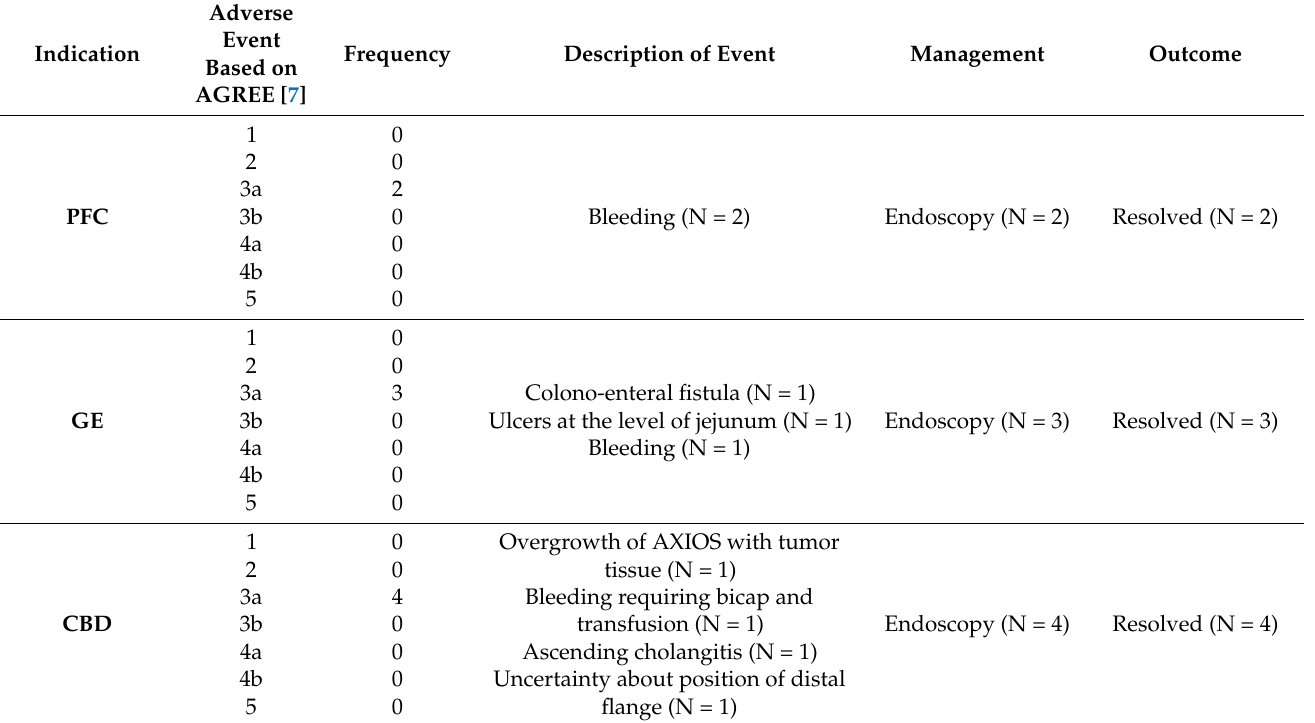
Table 4. Complications, management and outcome for respective LAMS